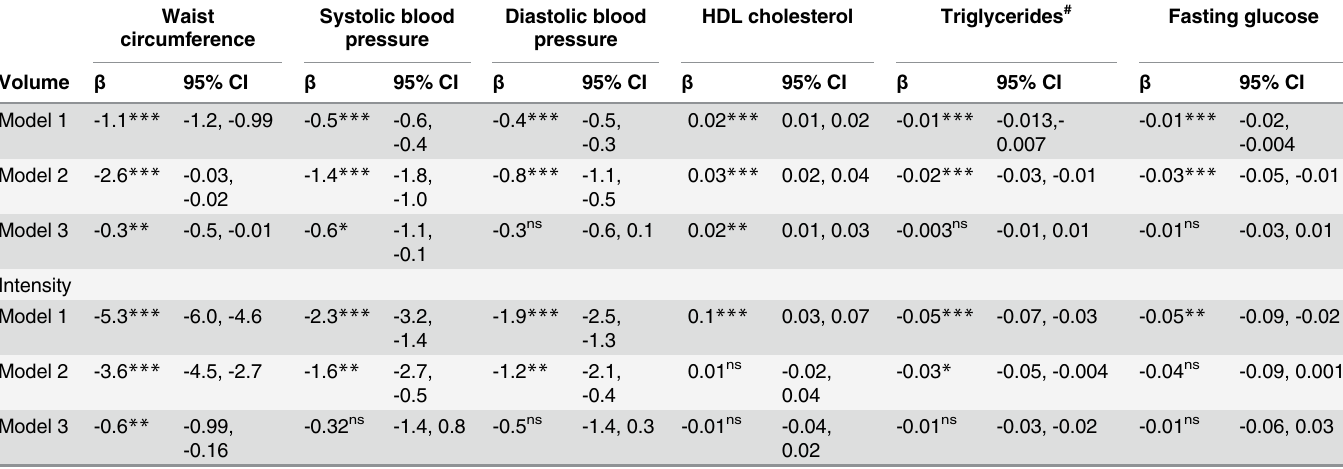
Table 3. Total mean MET-hours (volume) and intensity (MET) of PA in relation to components of metabolic syndrome. Waist Systolic blood Diastolic blood HDL cholesterol Triglycerides # Fasting circumference pressure pressure